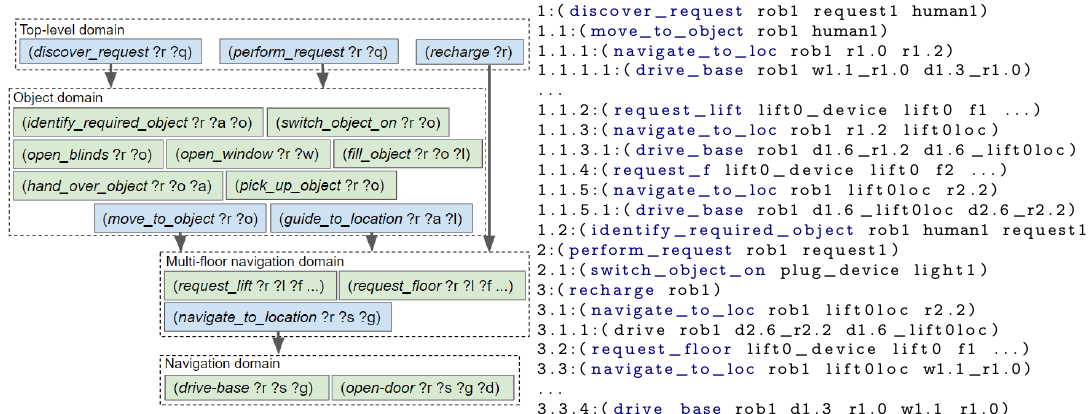
Figure 8. Action definitions split-up into three domain files. Executed actions when repeated groups of actions are separated.